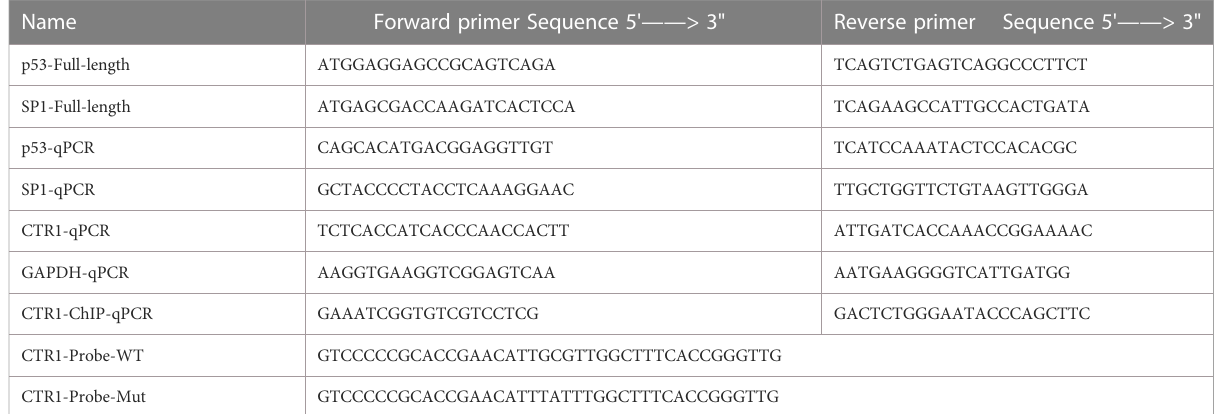
TABLE 1 Primer and probe